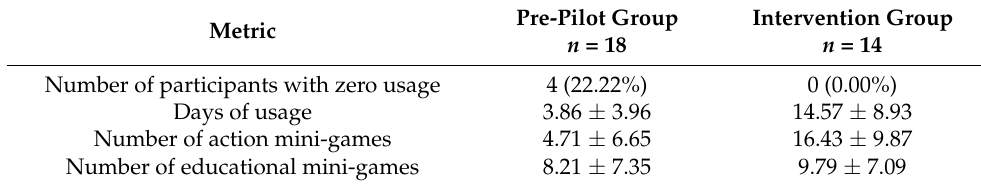
Table 5. Usage metrics of the ENDORSE game.